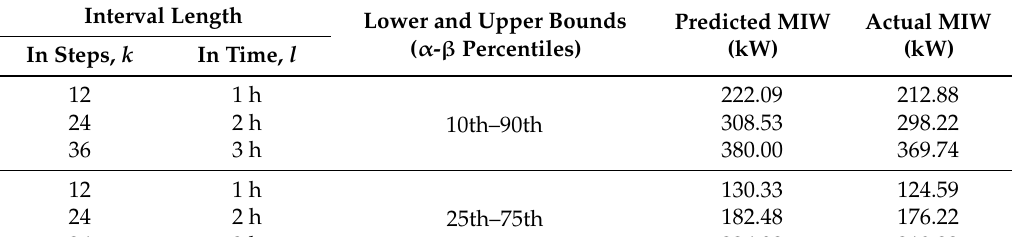
Table 6. Comparison of the mean interval width for intervals with different lengths and bounds.